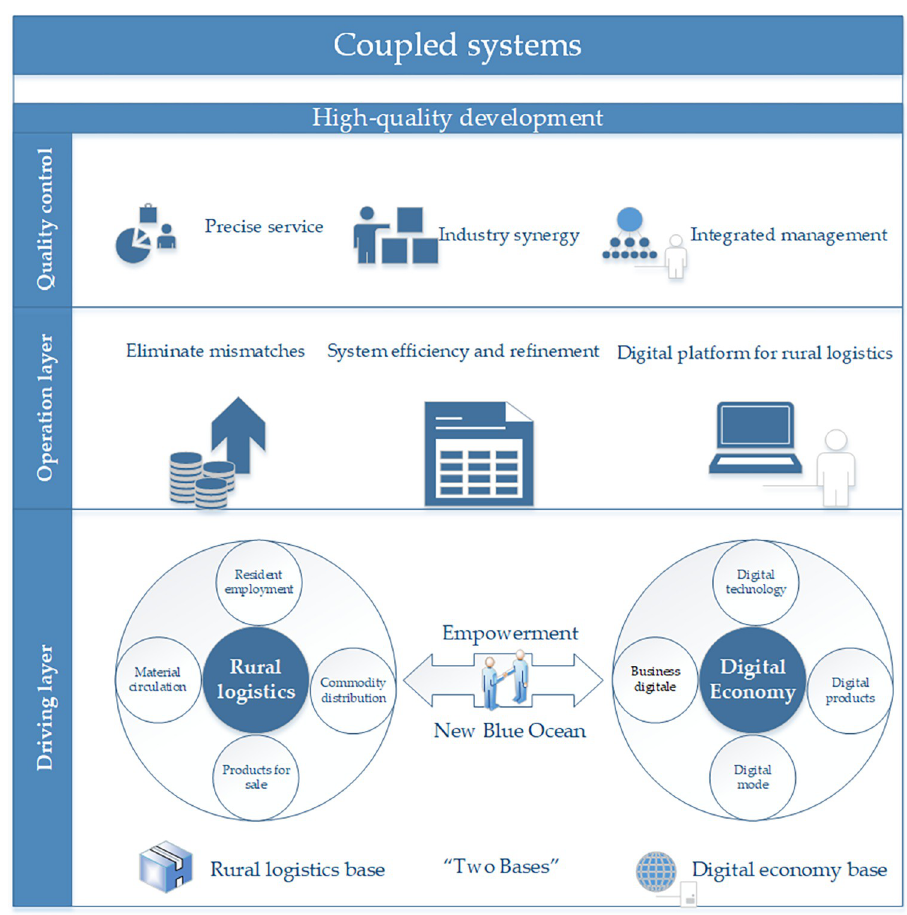
Fig 2. Mechanism of action in the coupled